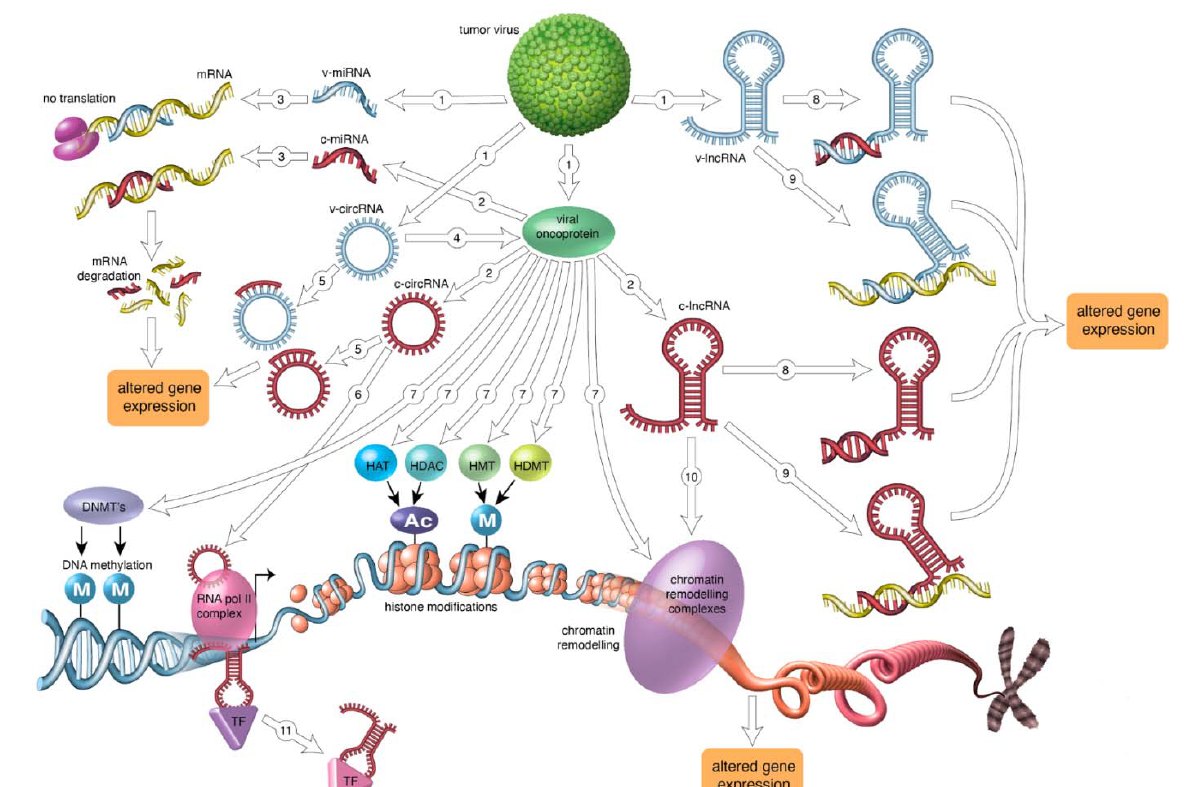
Figure 1. Epigenetic mechanisms by human tumor virus. (1) The virus encodes viral oncoproteins and its own v ‐ microRNA, v ‐ circRNA, and v ‐ lncRNA. (2) Viral oncoproteins induce the expression of cellular microRNA (c ‐ miRNA), c ‐ circRNA, and c ‐ lncRNA. (3) v ‐ miRNA and c ‐ miRNA can bind to target mRNA and induce mRNA degradation or prevent translation. (4) v ‐ circRNA can be translated into a viral oncoprotein. (5) v ‐ circRNA and c ‐ circRNA act as a miRNA sponge. (6) c ‐ circ interacts with the transcriptional machinery. (7) Viral oncoprotiens can regulate the expression of, can interact with, and can modulate the activity of DNA and histone modifying proteins and of components of chromatin remodeling complexes. (8) lncRNA sequesters miRNA. (9) lncRNA prevents translation of mRNA. (10) lncRNA recruits components of chromatin remodeling complexes. (11) lncRNA can modulate transcription by recruiting transcription factors (TF) or by sequestering TF to DNA.